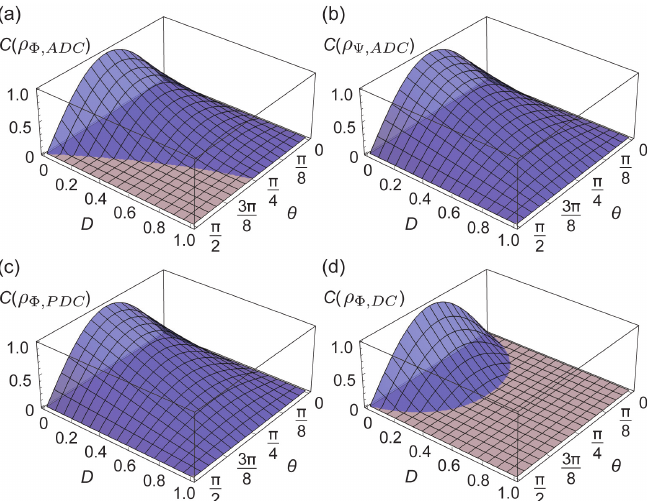
Figure 1. Theoretical results of concurrence (blue) as functions of D (= D A = D B ) and θ for ( a ) ρ Φ , ADC , ( b ) ρ Ψ , ADC , ( c ) ρ Φ , PDC , and ( d ) ρ Φ , DC . Above C = 0 planes indicate the existence of quantum entanglement. ESD occurs when the entangled state | Φ (cid:105) with θ > π /4 is under ADC, or any bipartite entangled state is under